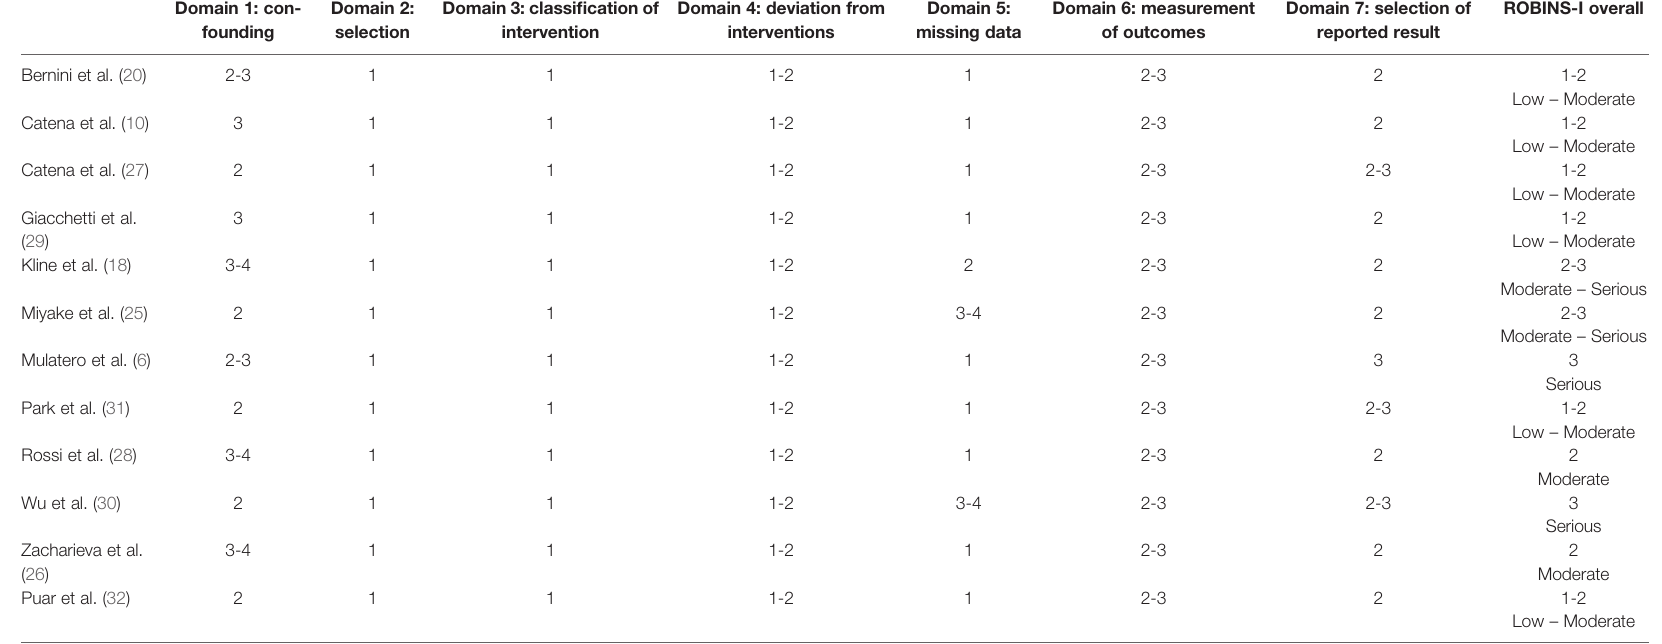
TABLE 2 | Range of overall assessment by study and bias